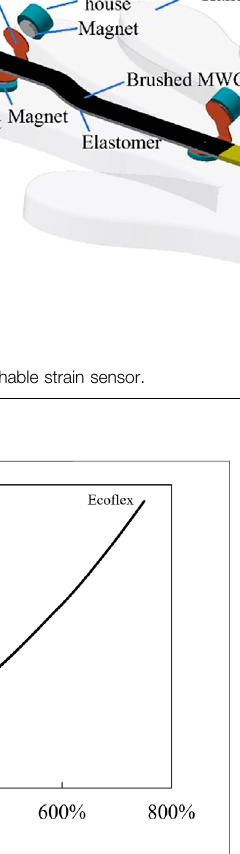
Frontiers in Robotics and AI |